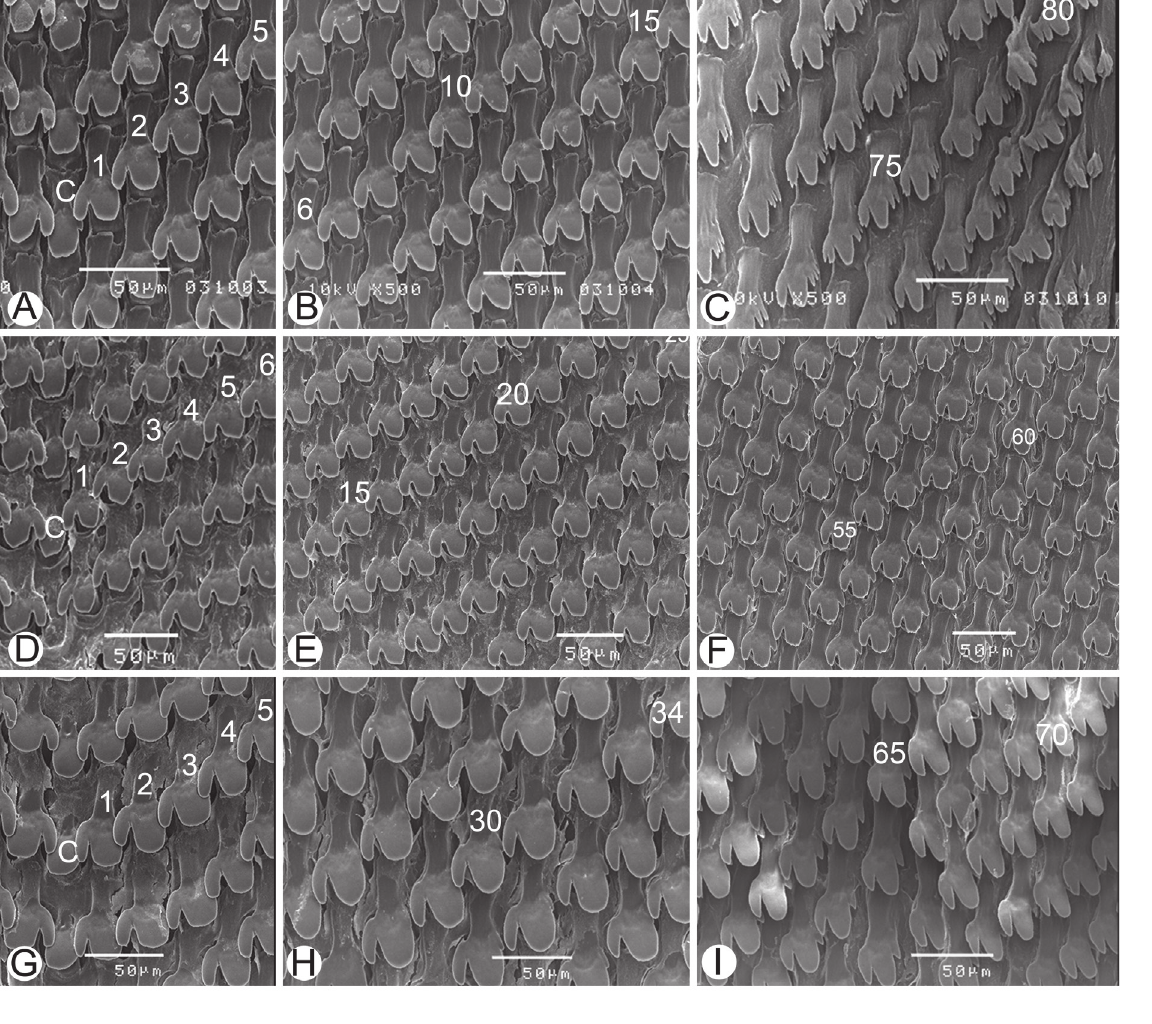
Fig. 12. SEM images of the radula. A–C . Amphidromus flavus (Pfeiffer, 1861) from Ban Na Deauy, Luang Phrabang, Laos (CUMZ 7027). D–F . Amphidromus xiengensis Morlet, 1891 from Ban Na Deauy, Luang Phrabang, Laos (CUMZ 7037). G–I . Amphidromus fuscolabris Möllendorff, 1898 from Ban Phone, Sekong, Laos (CUMZ 7041). A, D, G = central tooth with the first to fifth or sixth lateral teeth; B, E, H = lateral teeth with the tricuspid marginal teeth transition; C, F, I = outermost marginal teeth. Numbers indicate the order of the lateral and marginal teeth. Central tooth indicated by